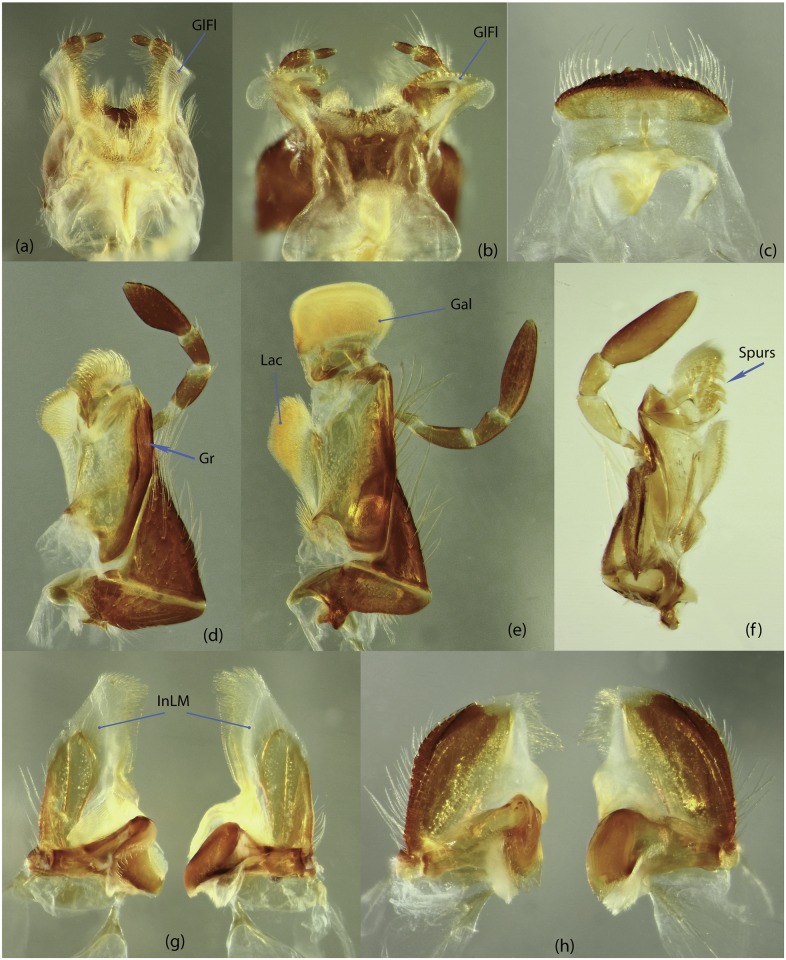
Mouthparts of Scarabaeinae.a, e, g, Macroderes mutilans; b-d, h, Byrrhidium namaquensis; f, Delopleurus sp.; a-b, mentum-glossae, dorsal view; c, epipharynx, dorsal view; d-f, left mandible, ventral view; g-h, mandibles, ventral view.